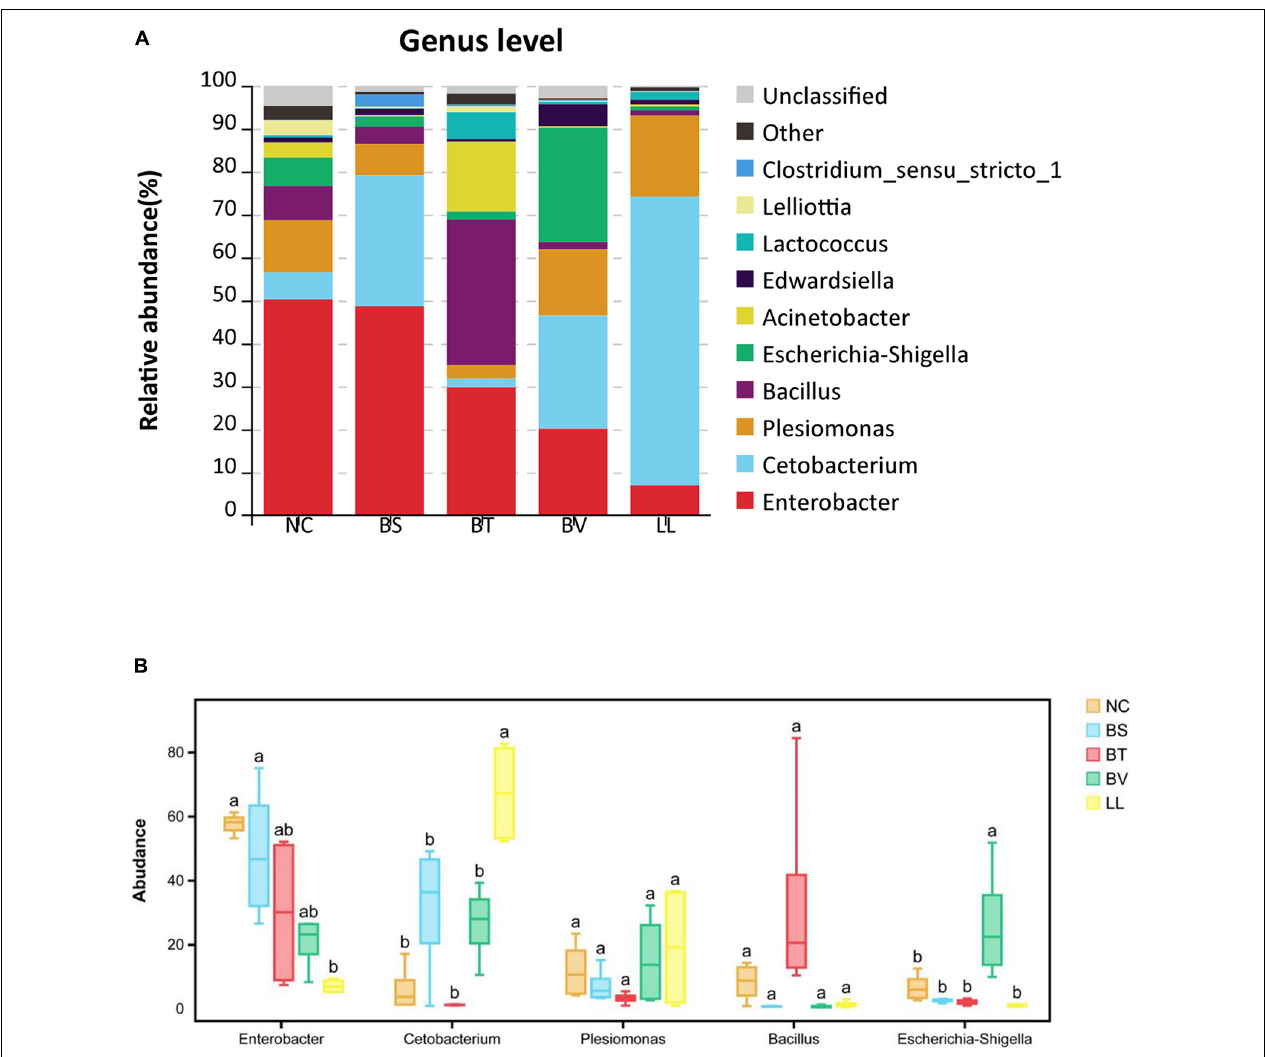
FIGURE 7 | The relative abundance of major bacterial genera in (A) barplot and (B) boxplot. Bars with different letters were significantly different ( p < 0.05). NC, control diet; BS, control diet containing 1 × 10 7 CFU/g of Bacillus siamensis ; BT, control diet containing 1 × 10 7 CFU/g of Bacillus tequilensis ; BV, control diet containing 1 × 10 7 CFU/g of Bacillus velezensis ; and LL, control diet containing 1 × 10 7 CFU/g of Lactococcus lactis